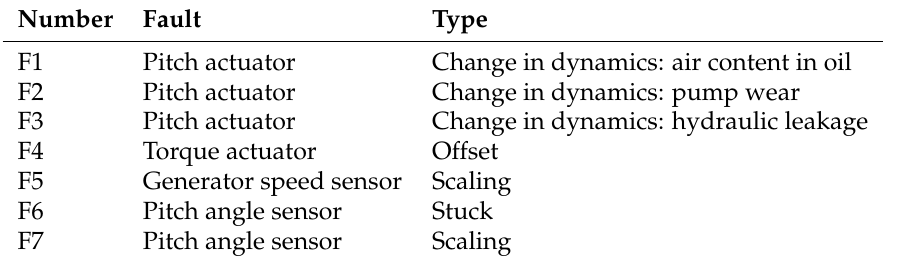
Table 2. Fault scenarios.